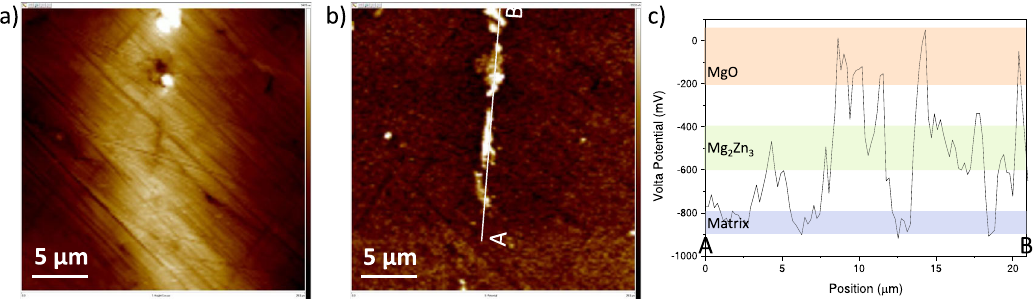
Fig. 7 SKPFM measurement of BJP Mg-Zn-Zr alloy surface. a Surface topology and b Volta potential mapping of the sinter neck in BJP-87, with the c Volta potential line scan of the secondary phases marked in ( b